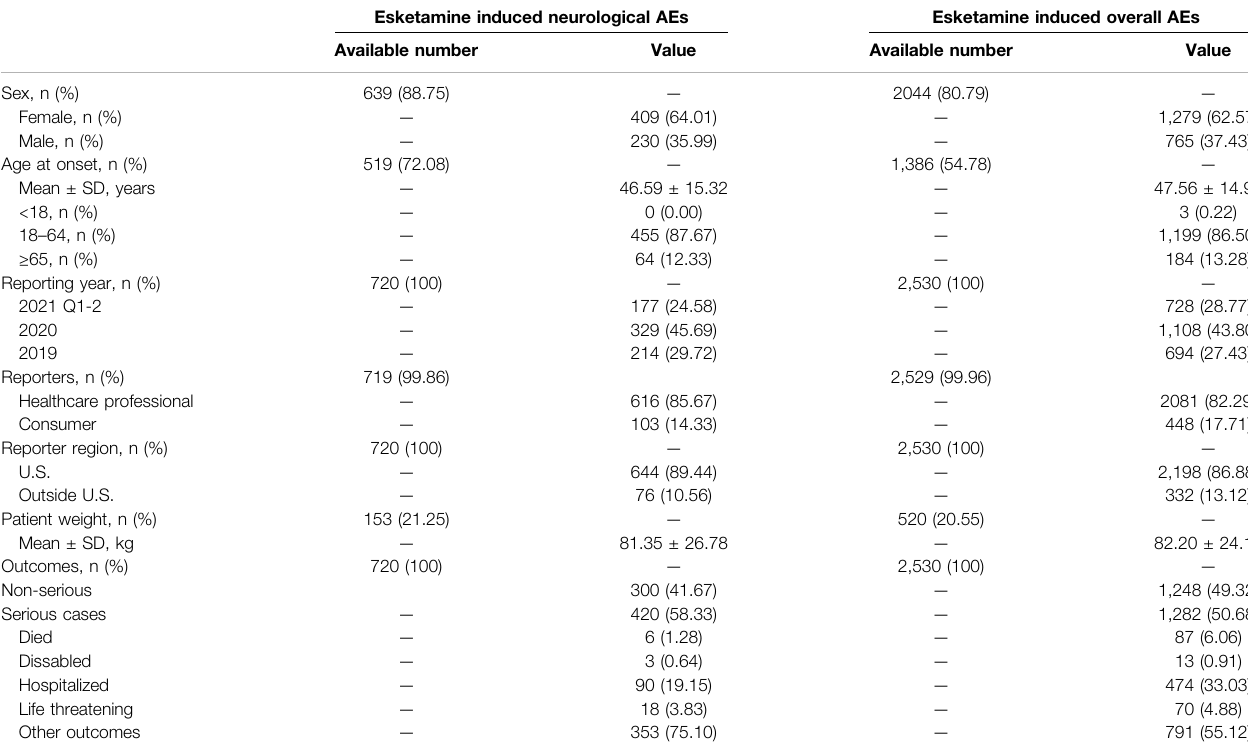
TABLE 1 | Clinical characteristics of patients with esketamine-induced adverse